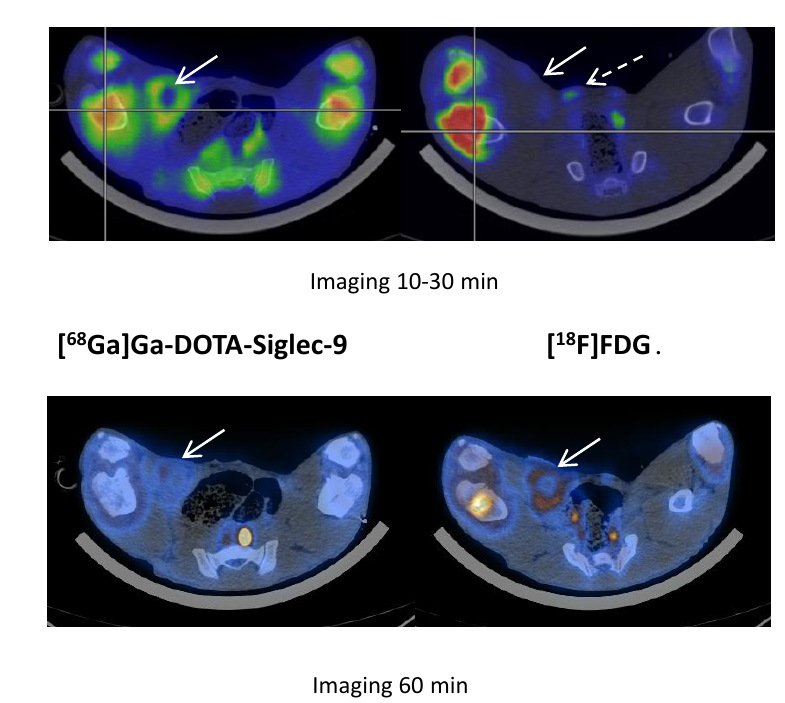
Figure 8. [ 68 Ga]Ga-DOTA-Siglec-9 compared to [ 18